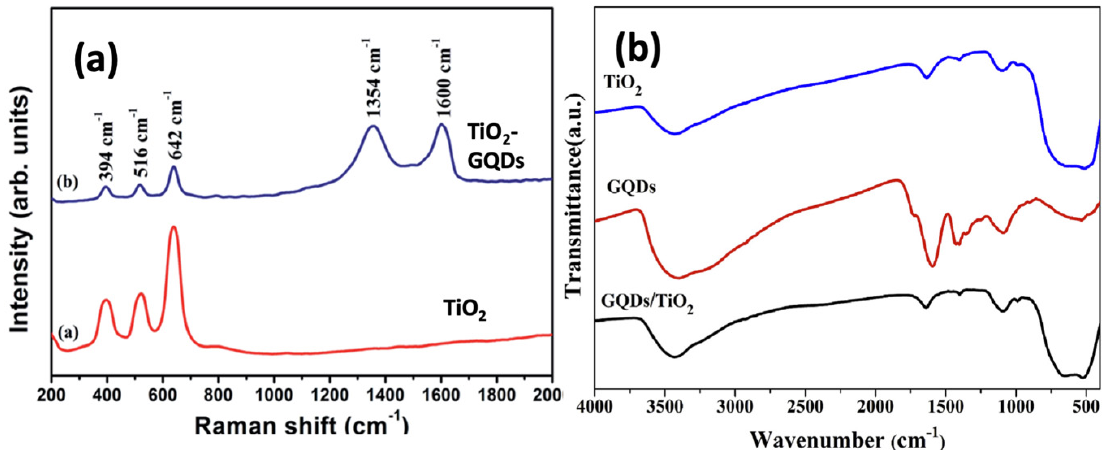
Figure 17. ( a ) Raman and ( b ) FTIR spectra of TiO 2 , GQDs, and TiO 2 -GQD nanocomposites. ( a ) Reproduced from [93] with permission from The Royal Society of Chemistry. ( b ) Reprinted with permission from reference [89]. Copyright 2016 Elsevier.